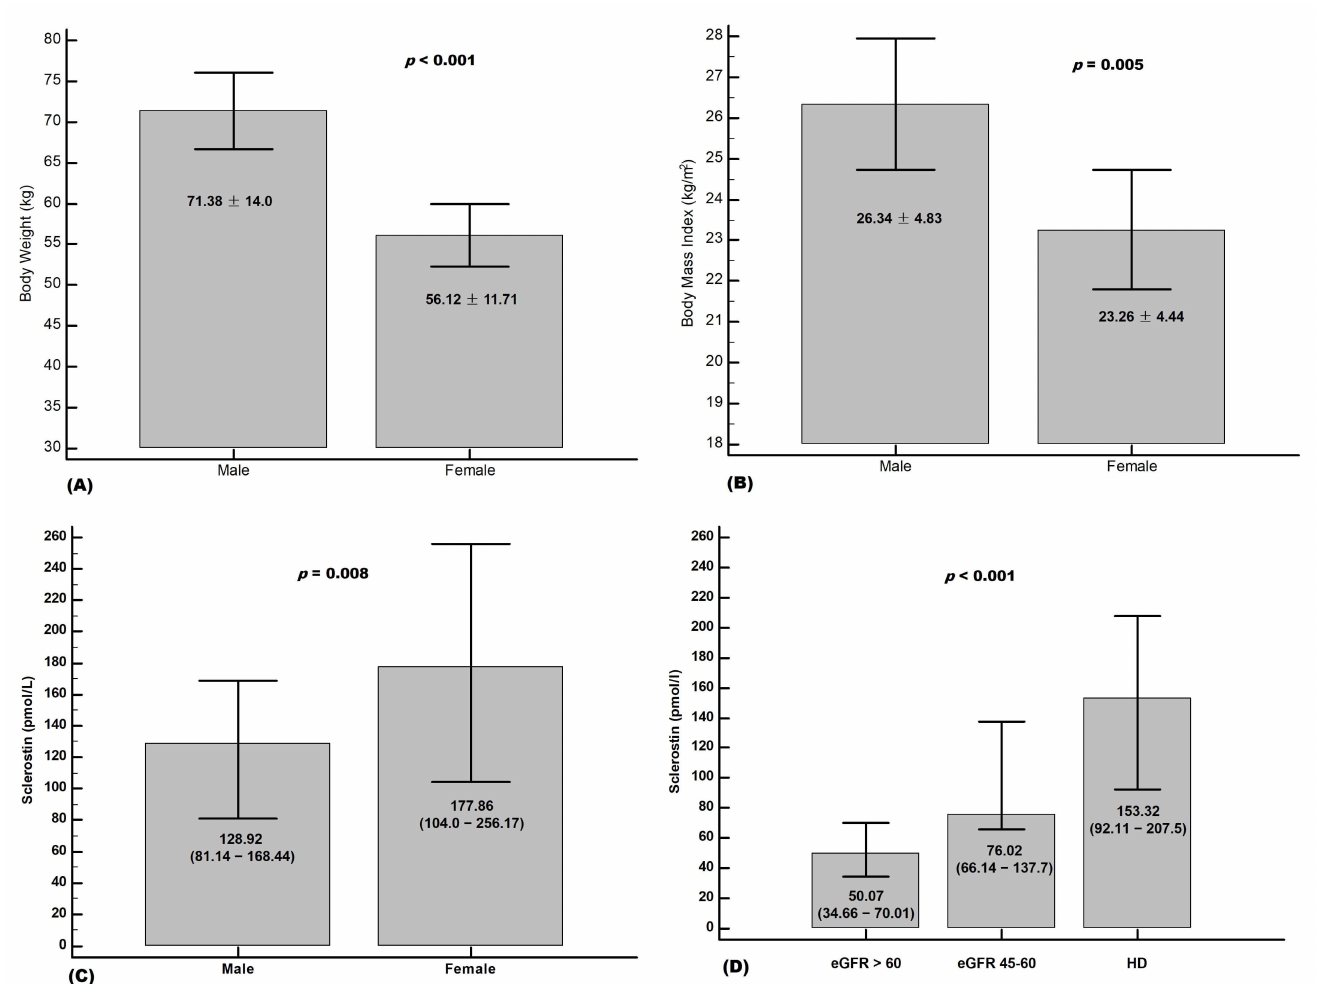
Figure 1. Difference of ( A ) body weight, ( B ) body mass index, ( C ) sclerostin between male and female HD patients, and ( D ) levels of sclerostin among HD patients, eGFR more than 60 min/min/1.73 m 2 and 45–60 mL/min/1.73 m 2